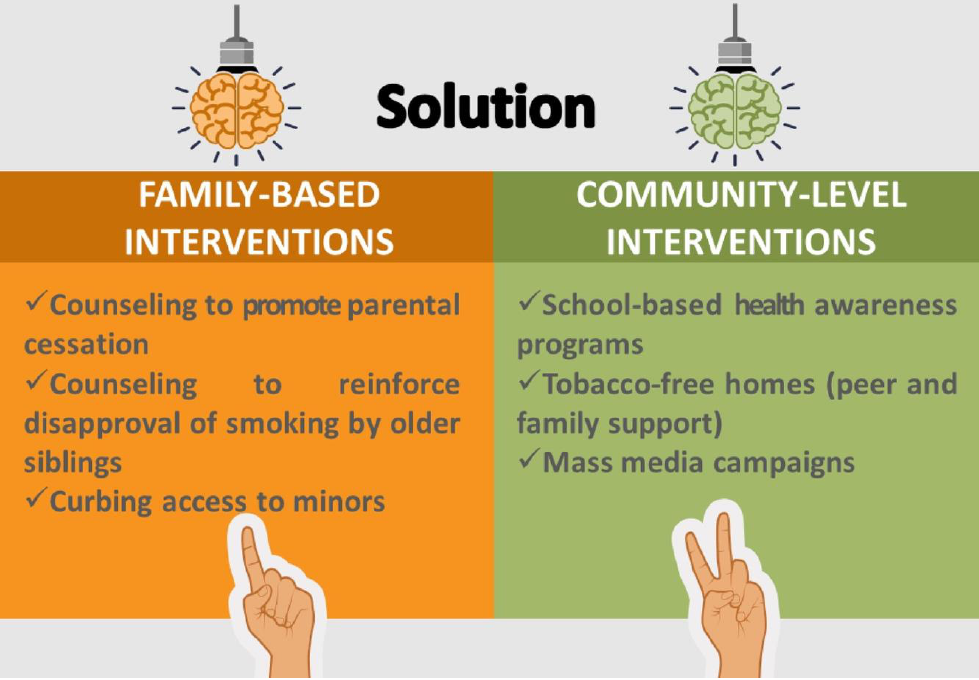
Figure 2. Family and community-level solutions to curb tobacco addiction.